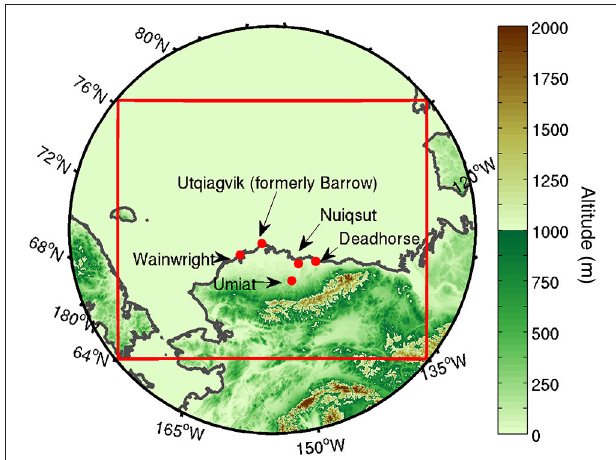
FIGURE 1 | The WRF simulation domain (red box) with terrain heights (m). This downscaling product is specifically focused on the region of Arctic Coastal Plain and a small part of northern foothills of the Brooks Range with the domain enclosed by the red